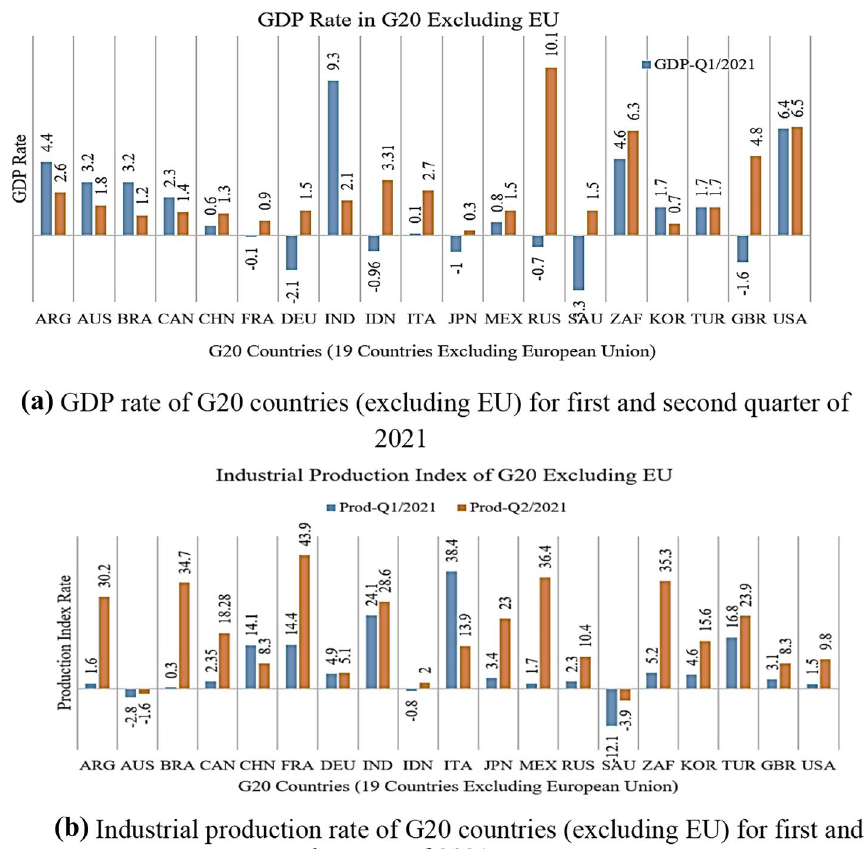
Fig. 10 a GDP rate of G20 countries (excluding EU) for first and second quarter of 2021. b Industrial production rate of G20 countries (excluding EU) for first and second quarter of